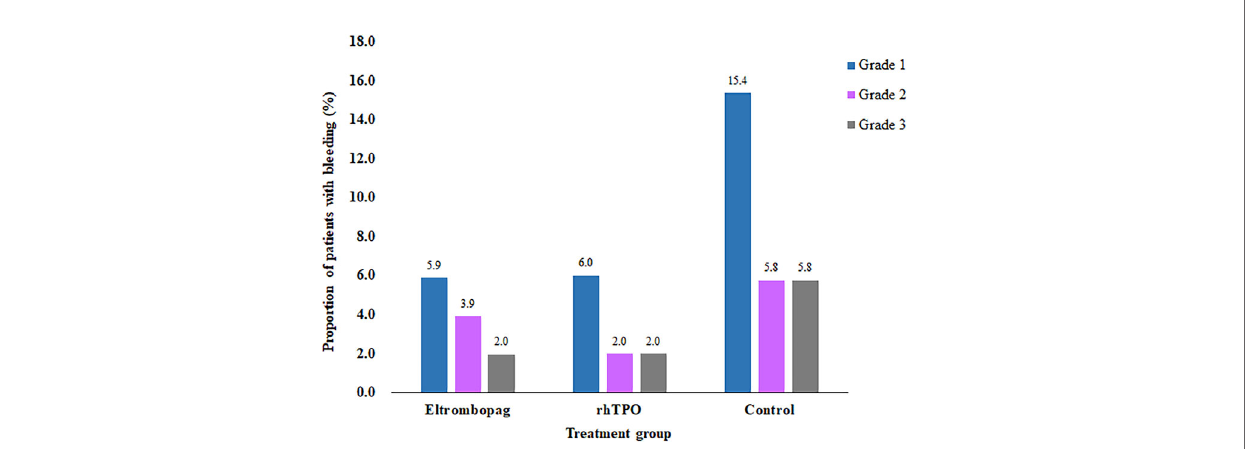
FIGURE 2 | Proportion of bleeding by WHO grades among the three groups.